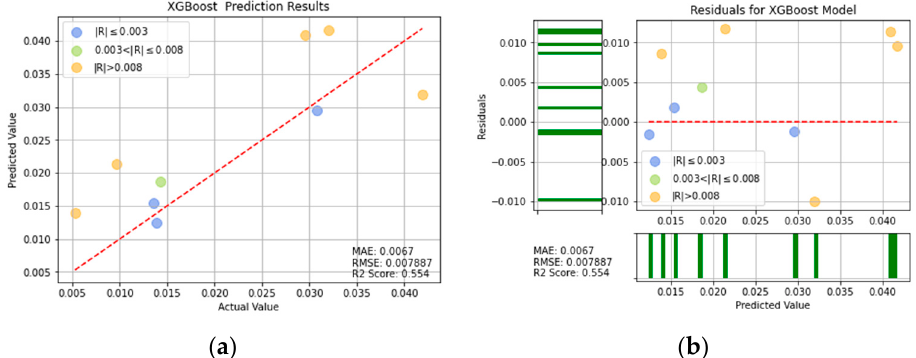
Figure 18. XGBoost prediction results: ( a ) comparison of actual and predicted precision values, and ( b ) residual plot.